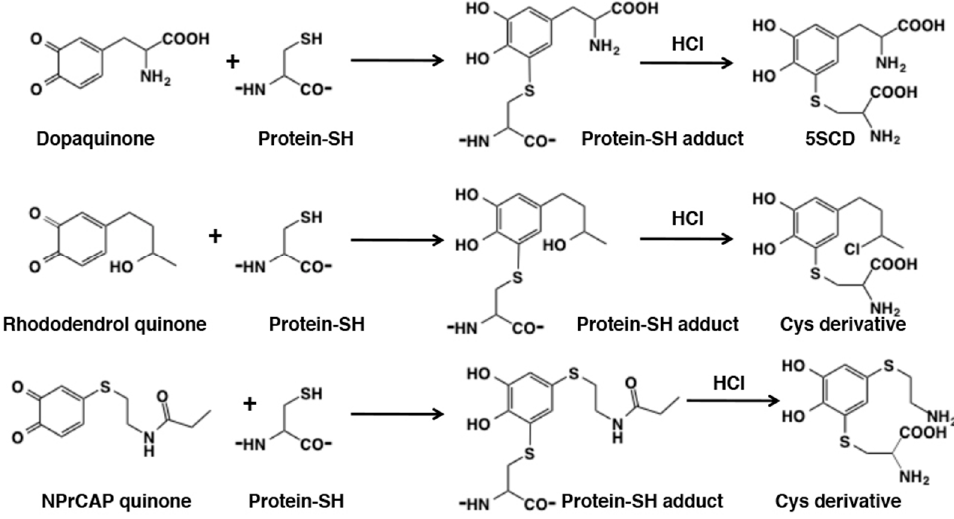
Figure 24. Reaction of o -quinones with protein-SH and acid hydrolysis of the adducts to liberate cysteinyl derivatives [30,120–122].